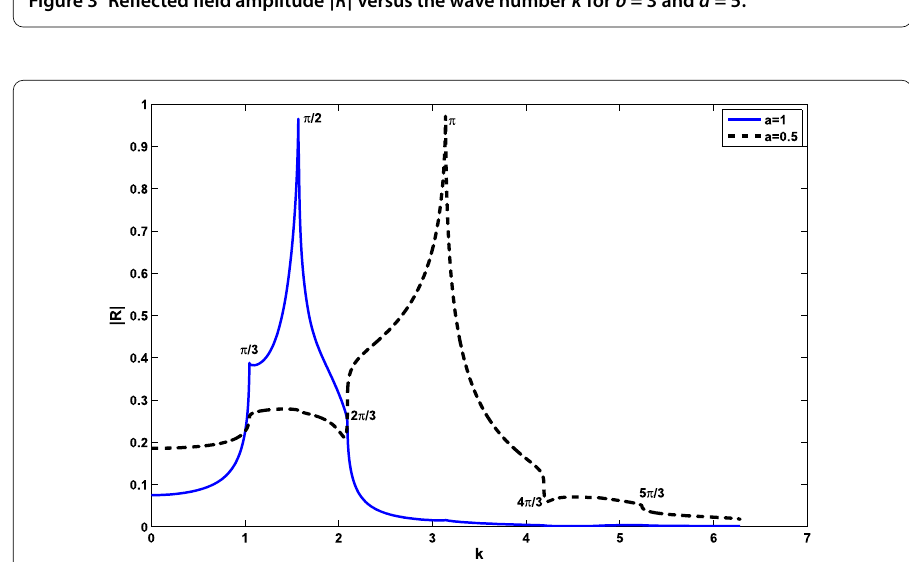
Figure 4 Reflected field amplitude | R | versus the wave number k for b = 2 and d =